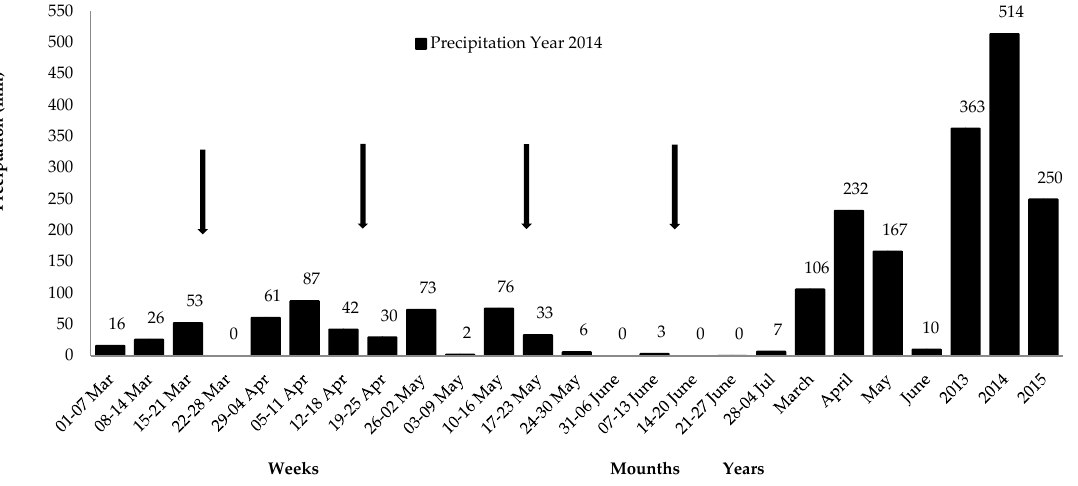
Figure 1. Weekly and monthly precipitation from March to June 2014, and yearly precipitation during the assessment, in 2013, 2014, and 2015. Arrows indicate collection weeks in each month. Source: [10].